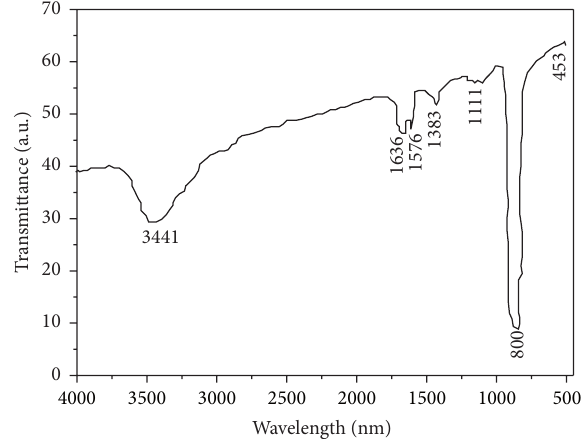
Figure 2: The FT-IR spectrum of CaWO 4 nanocrystals synthesized under 120 ∘ C, for